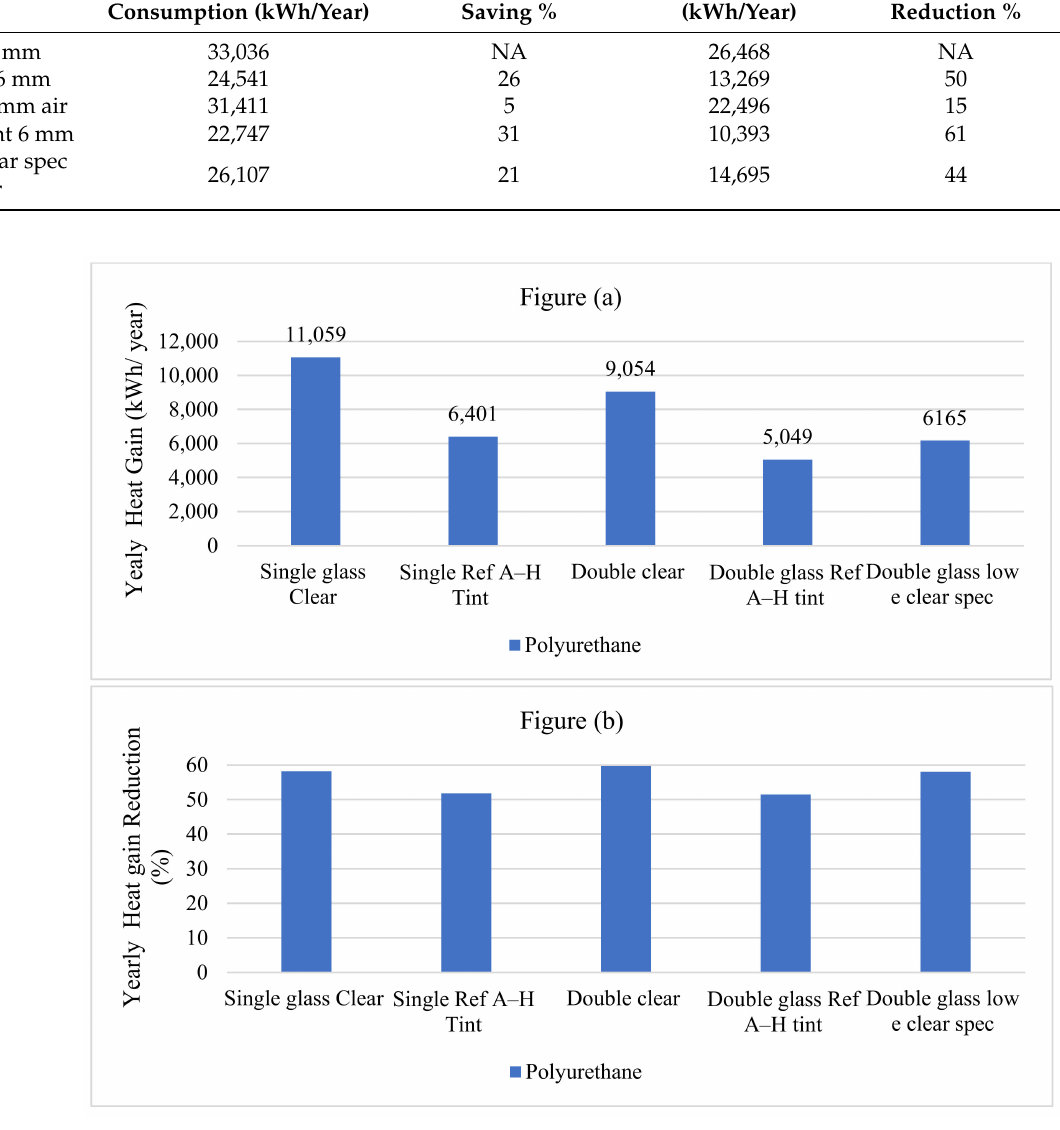
Figure 4. Effect of window shutters for different glass type on heat gain ( a ) and the correlated yearly heat reduction ( b